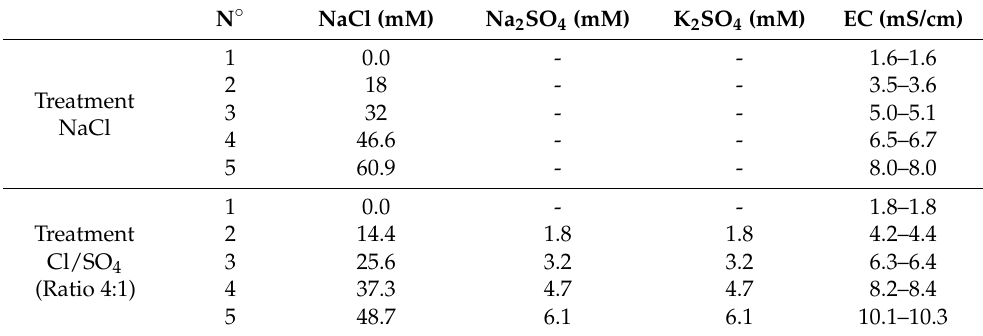
Table 3. Salt concentrations added to the synthetic N medium during the first two salt experiments. The EC values were temperature corrected, and the interval gives the maximal range of measured values (at t0 and t1). Treatment n ◦ 1 of both experiments served as a reference. N ◦ NaCl (mM) Na 2 SO 4